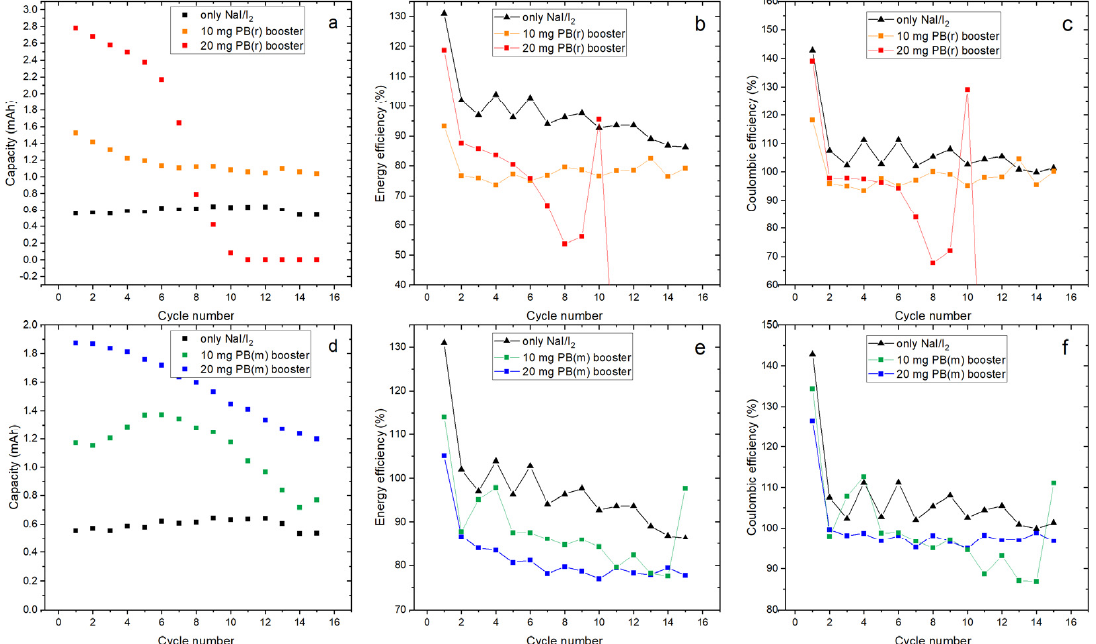
Figure 4. Discharge capacities, energy efficiencies and Coulombic efficiencies for the cells over the first 15 cycles using rhombohedral ( a – c ) or monoclinic boosters ( d – f ).